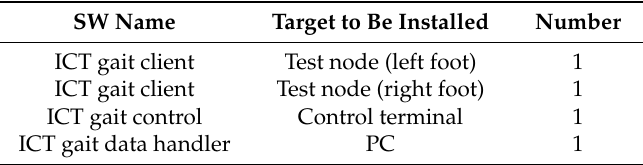
Table 2. System SW